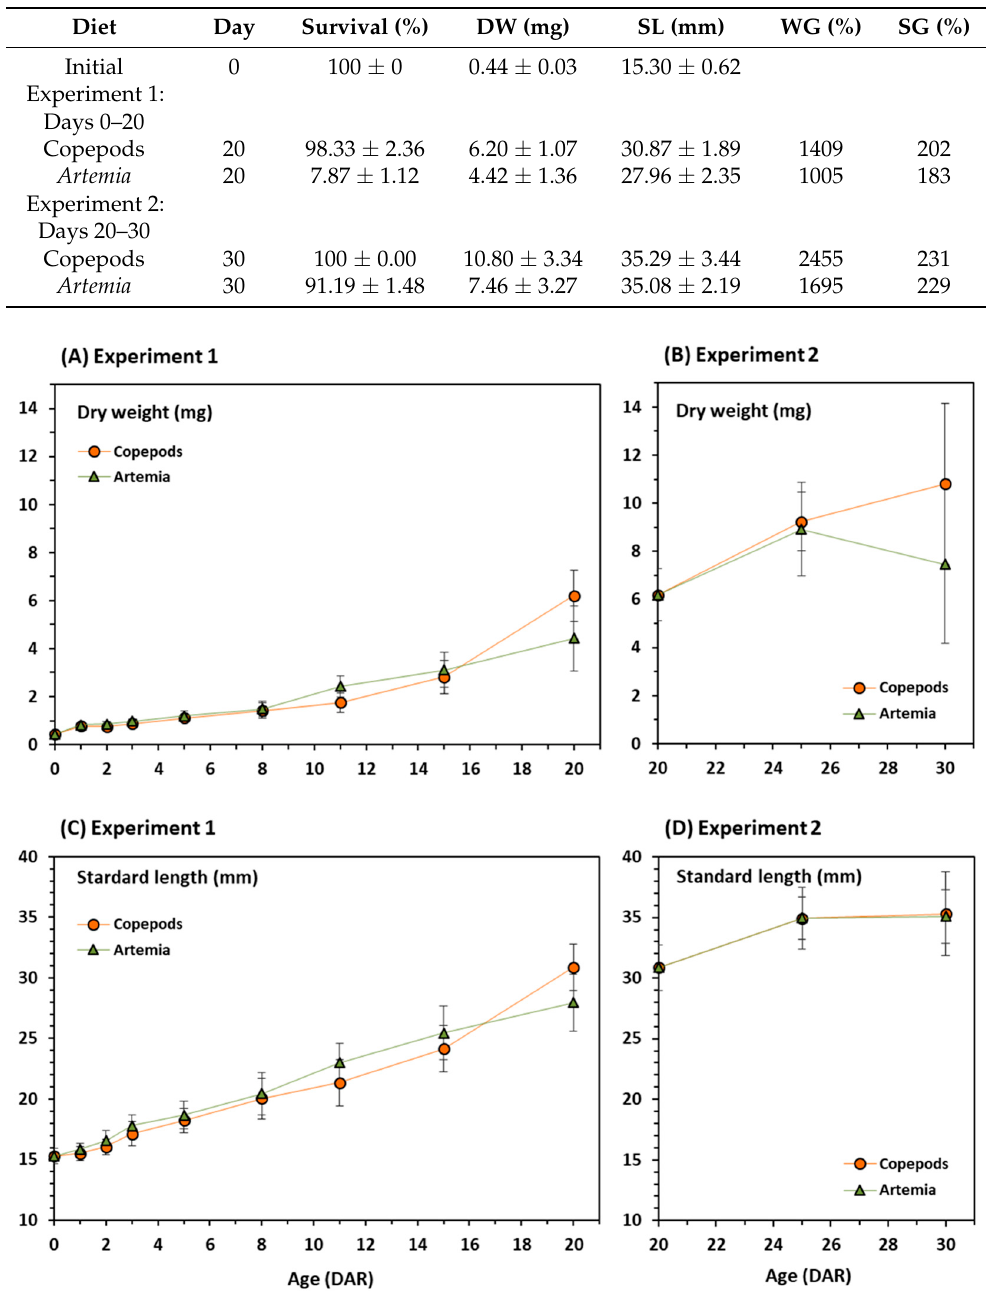
Table 1. Survival, individual dry weight (DW), standard length (SL), and percentage of weight and size gain (WG and SG, respectively) of 0-, 20- and 30-days old seahorses Hippocampus guttulatus fed on two feeding regimes (means ± standard deviations).